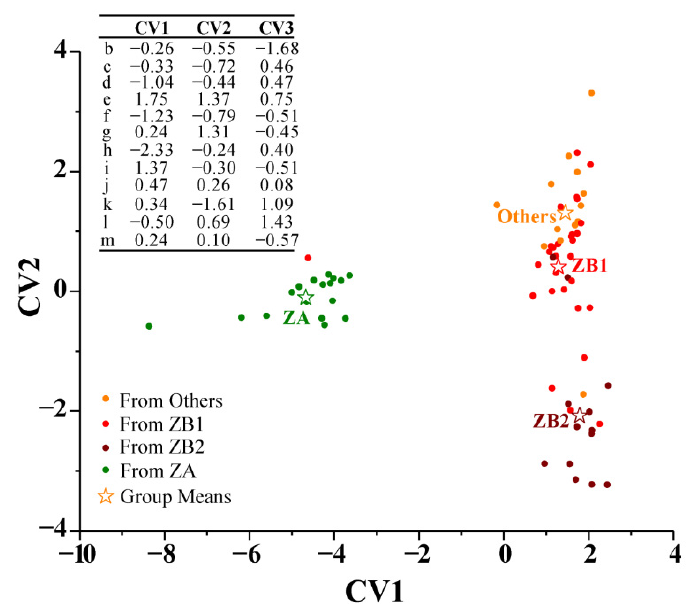
Figure 3. Discriminant analysis of prickly ash pericarps from 72 plantations based on volatile oil profiling of pericarps. Sample codes or spots with the same colors represent the samples belonging to the same group; CV represents canonical variable; ZA, samples with green pericarps ( n = 17) derived from species of Z. armatum ; ZB1, samples with red pericarps represented by Hancheng ( n = 29) derived from species of Z. bungeanum ; ZB2, samples with red pericarps represented by Fengxian ( n = 13) derived from species of Z. bungeanum ; others, samples with red pericarps, a clade of several species ( n = 13), not derived from species of Z. bungeanum ; b, alfa-myrcene; c, D-limonene; d, alfa-pinene; e, alfa-ocimene; f, gamma-terpinene; g, terpinolene; h, linalool; i, terpinen-4-ol; j, terpineol; k, linalyl acetate; l, alfa-terpinyl acetate; m, geranyl acetate.